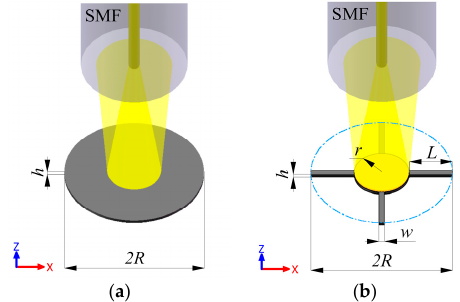
Figure 2. Schematic illustration of the membrane structure for detecting PDs: ( a ) intact membrane (IM); ( b ) beam-supported membrane (BSM).